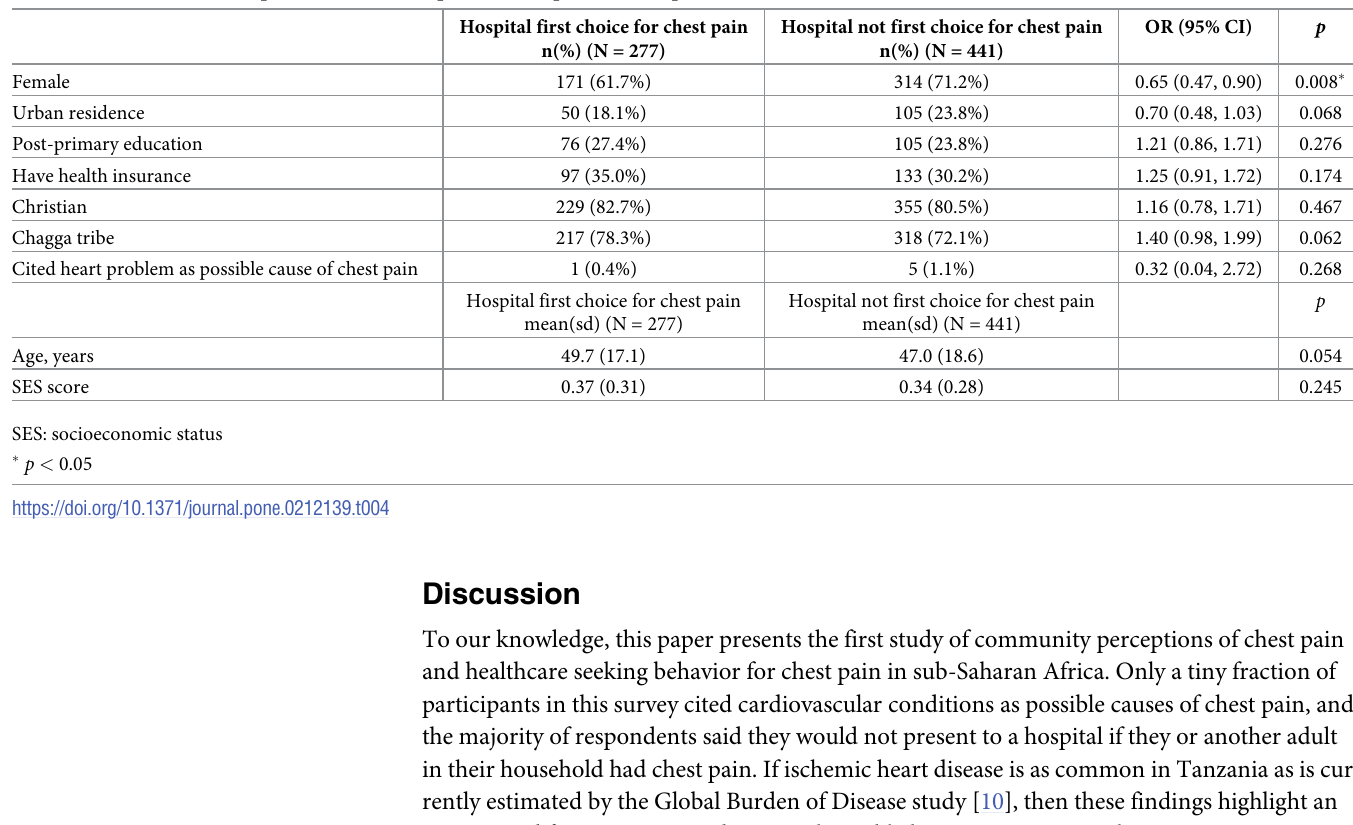
Table 4. Characteristics of respondents who would present to hospital for chest pain versus those who would not, northern Tanzania,